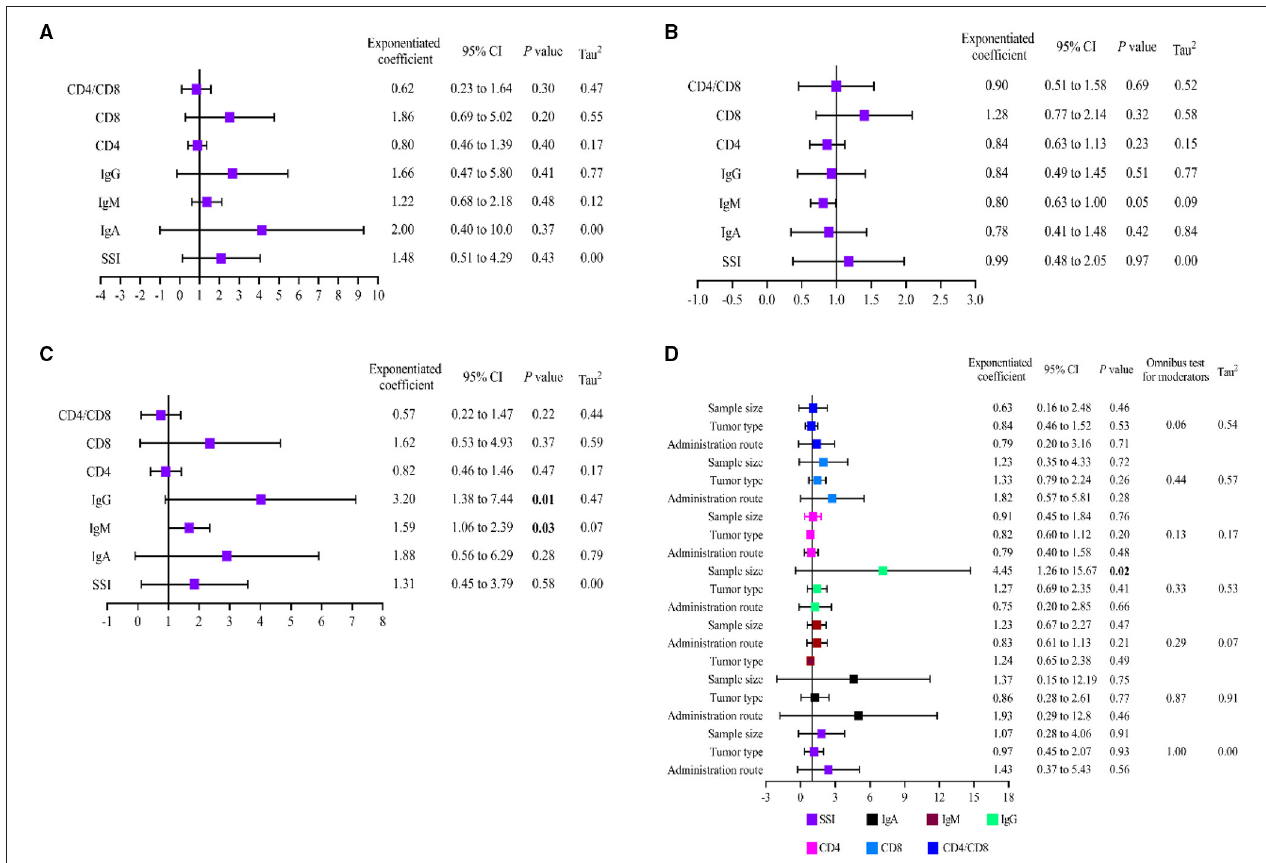
FIGURE 8 | Results of metaregression analysis. (A) Univariate analysis of administration route; (B) Univariate analysis of tumor type; (C) Univariate analysis of total sample size; (D) Multivariate analysis of all covariates. SSI, surgical site